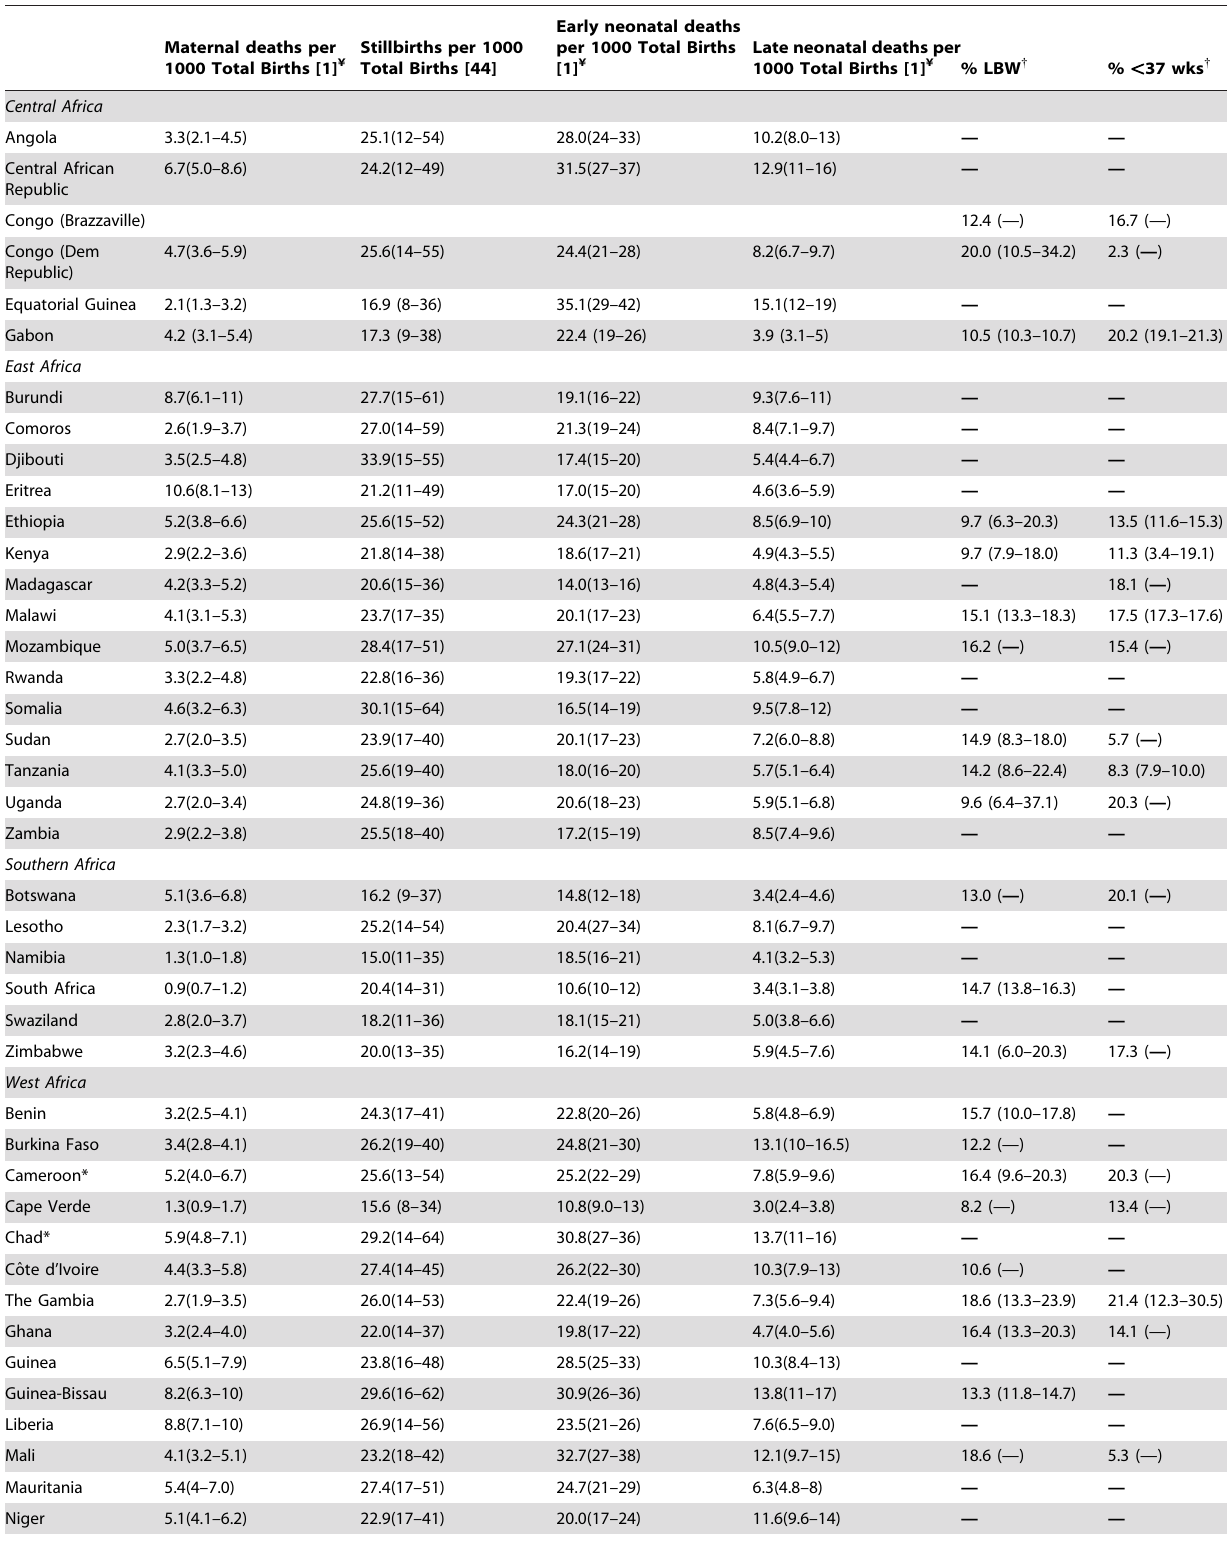
Table 4. Expected number of maternal and neonatal deaths and stillbirths for a hypothetical cohort of pregnant women corresponding to 1,000 births in Sub-Saharan Africa and the proportion of live-born infants expected to be low birth weight or